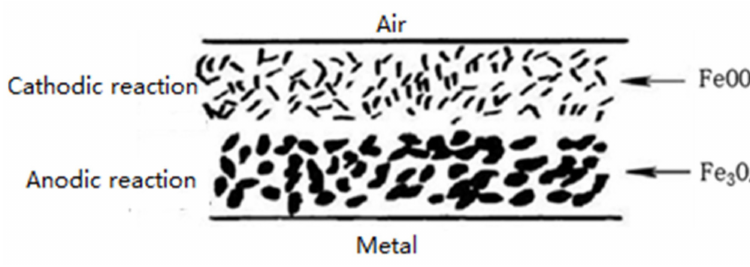
Figure 11. Corrosion